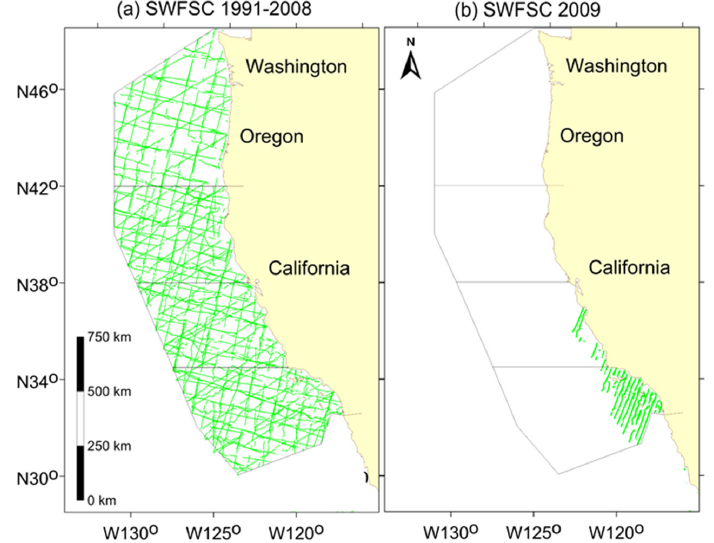
Figure 1. Completed transects for the Southwest Fisheries Science Center systematic ship surveys